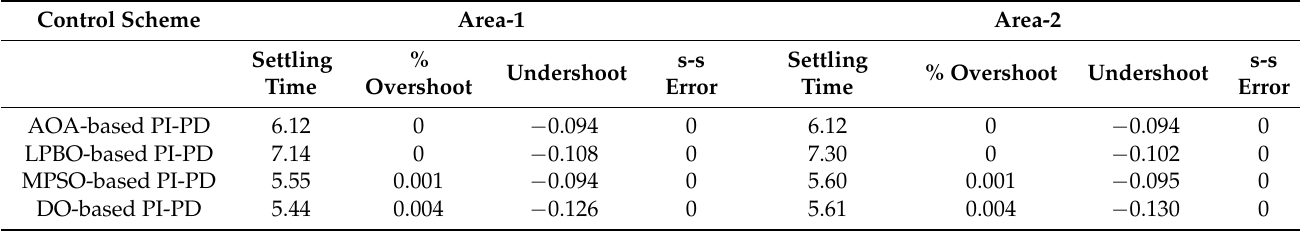
Figure 8. Tie-line power deviation responses in a two-area multi-source IPS.